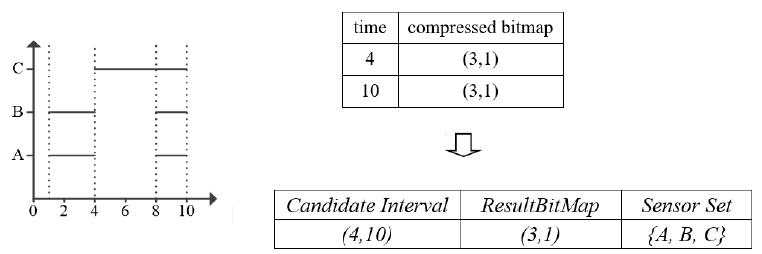
Figure 6. Example for Phase I.